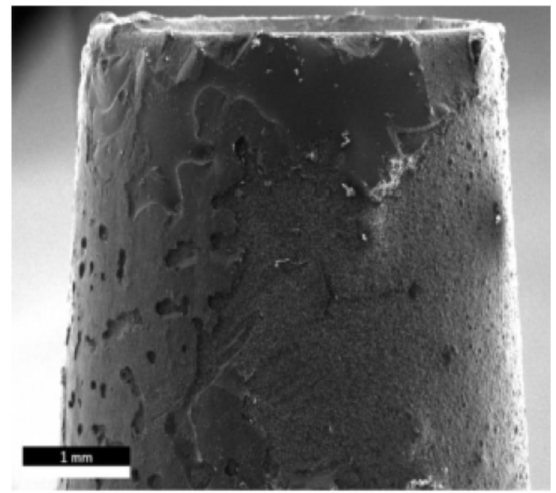
Figure 5. Corresponding to the EDX analysis shown in Figure 4, this figure shows the scanning electron microscopy (SEM) analysis of the same